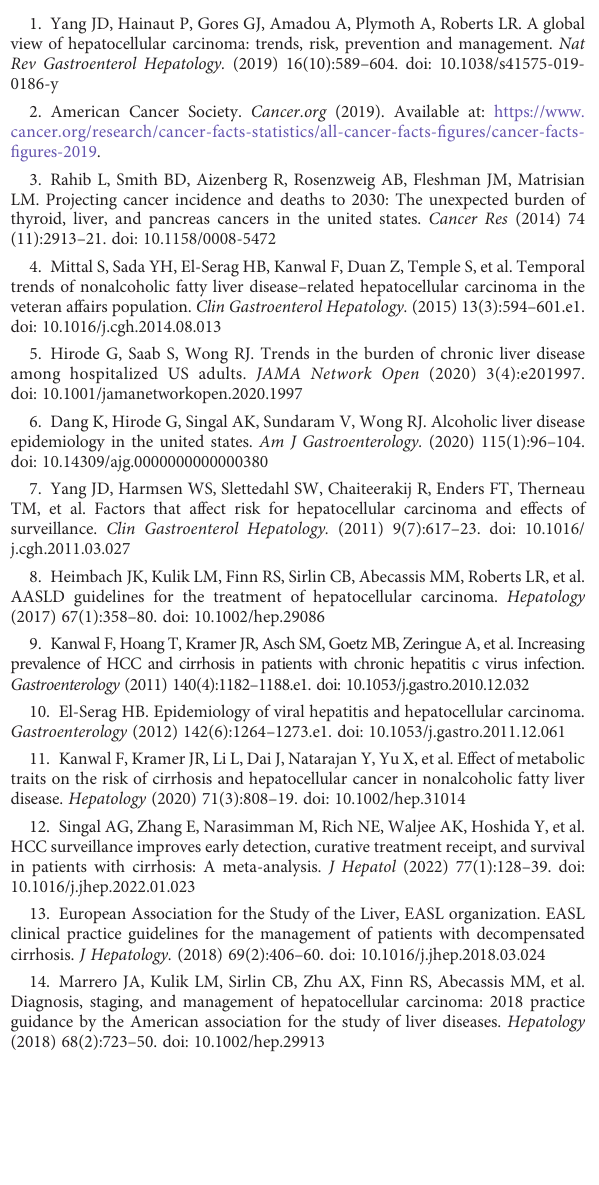
SUPPLEMENTARY TABLE 5 Thefrequencyoftumor-related5,155variantsintumor/controlsampleswere comparedwithFisher'sexactprobabilitytestundervariousgroupsettings,i.e., HCC plasma vs. all the controls (normal plasma and cirrhosis plasma), HCC tumorvsallthecontrols(normalplasmaandcirrhosisplasma),HCCvesiclevs allthecontrols(normalplasmaandcirrhosisplasma),andalltheHCCsamples (plasma, tumor and vesicles) vs. all the controls (normal plasma and cirrhosis plasma).Variants are sorted on the basis of decreasing proportion in HCC tumors.ColumnsshowingproportionofvariantsinHCCtumors (columnDG) and p value between HCC tumors and all non tumor controls (column DQ) are highlighted in gray color. HCC - all includes all samples, tumors, plasma and extracellular vesicles from HCC patients. Tumor-all includes both HCC